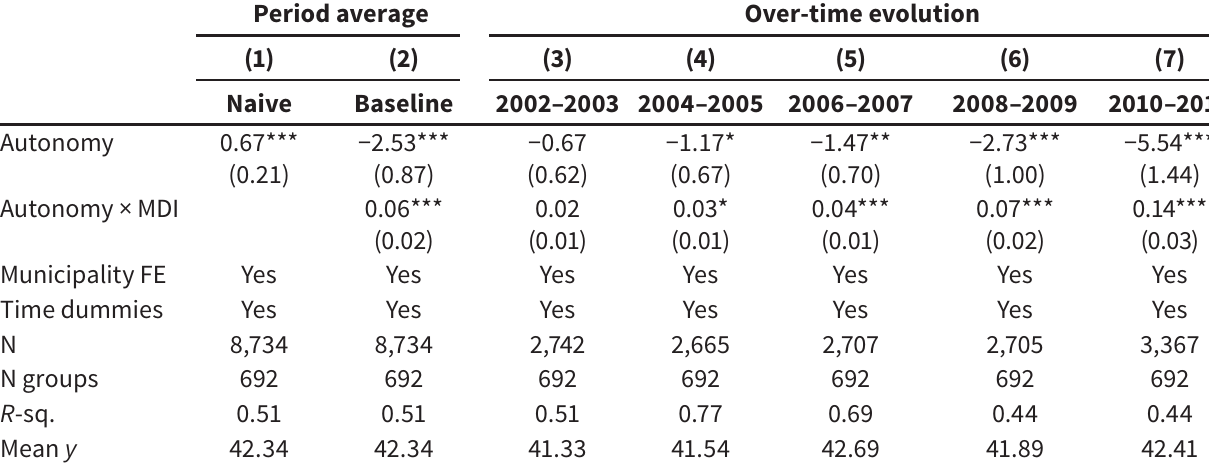
The effect of municipal autonomy on test scores Period